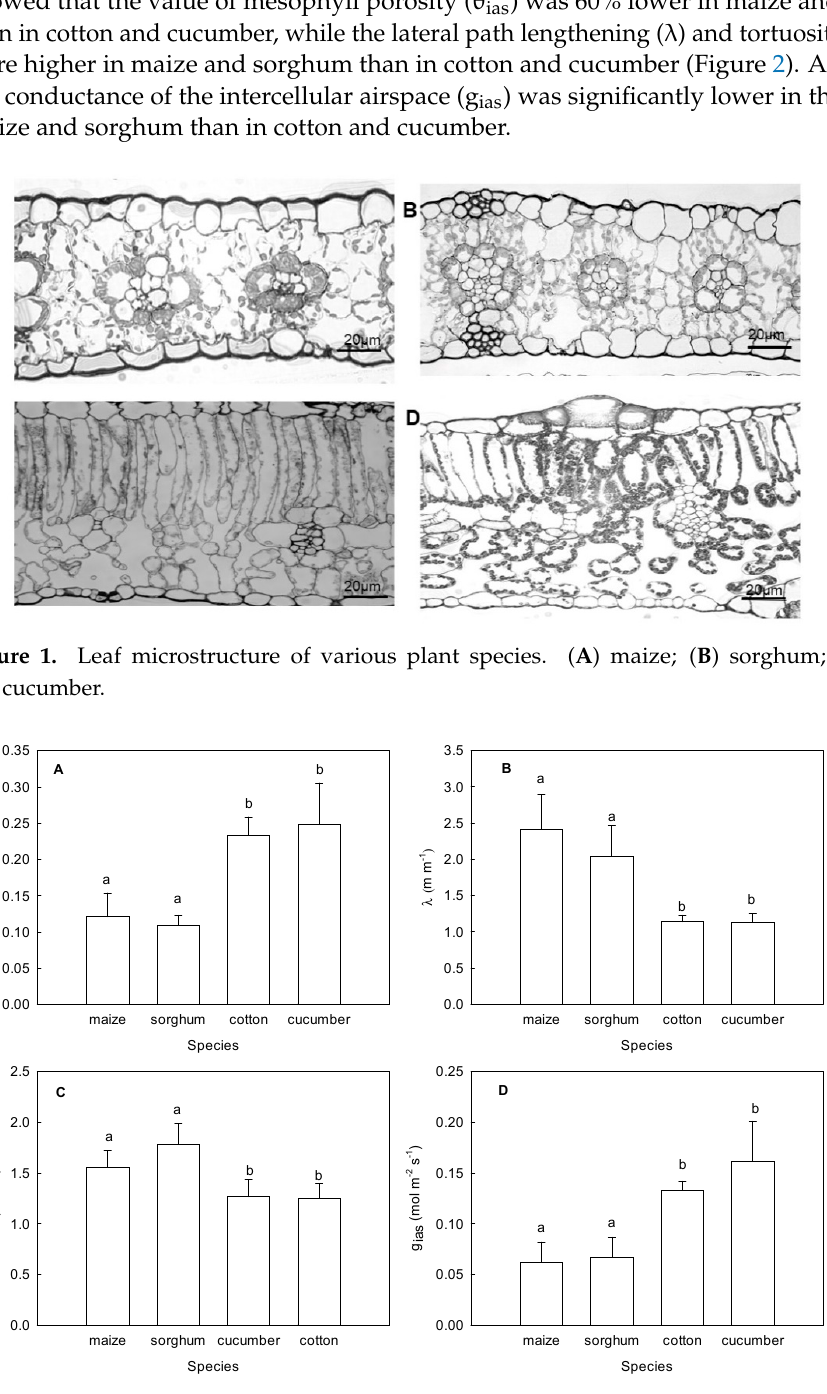
Figure 2. The differences in mesophyll porosity ( θ ias ), lateral path lengthening ( λ ), tortuosity factor ( τ ), and gaseous conductance of the intercellular airspace (g ias ) in maize, sorghum, cucumber, and cotton. ( A ) mesophyll porosity; ( B ) lateral path lengthening; ( C ) tortuosity factor; ( D ) gaseous conductance of the intercellular airspace. Data are means ± standard error (n ≥ 3); different lower- case letters indicate significant differences between different species at the p < 0.05 level.